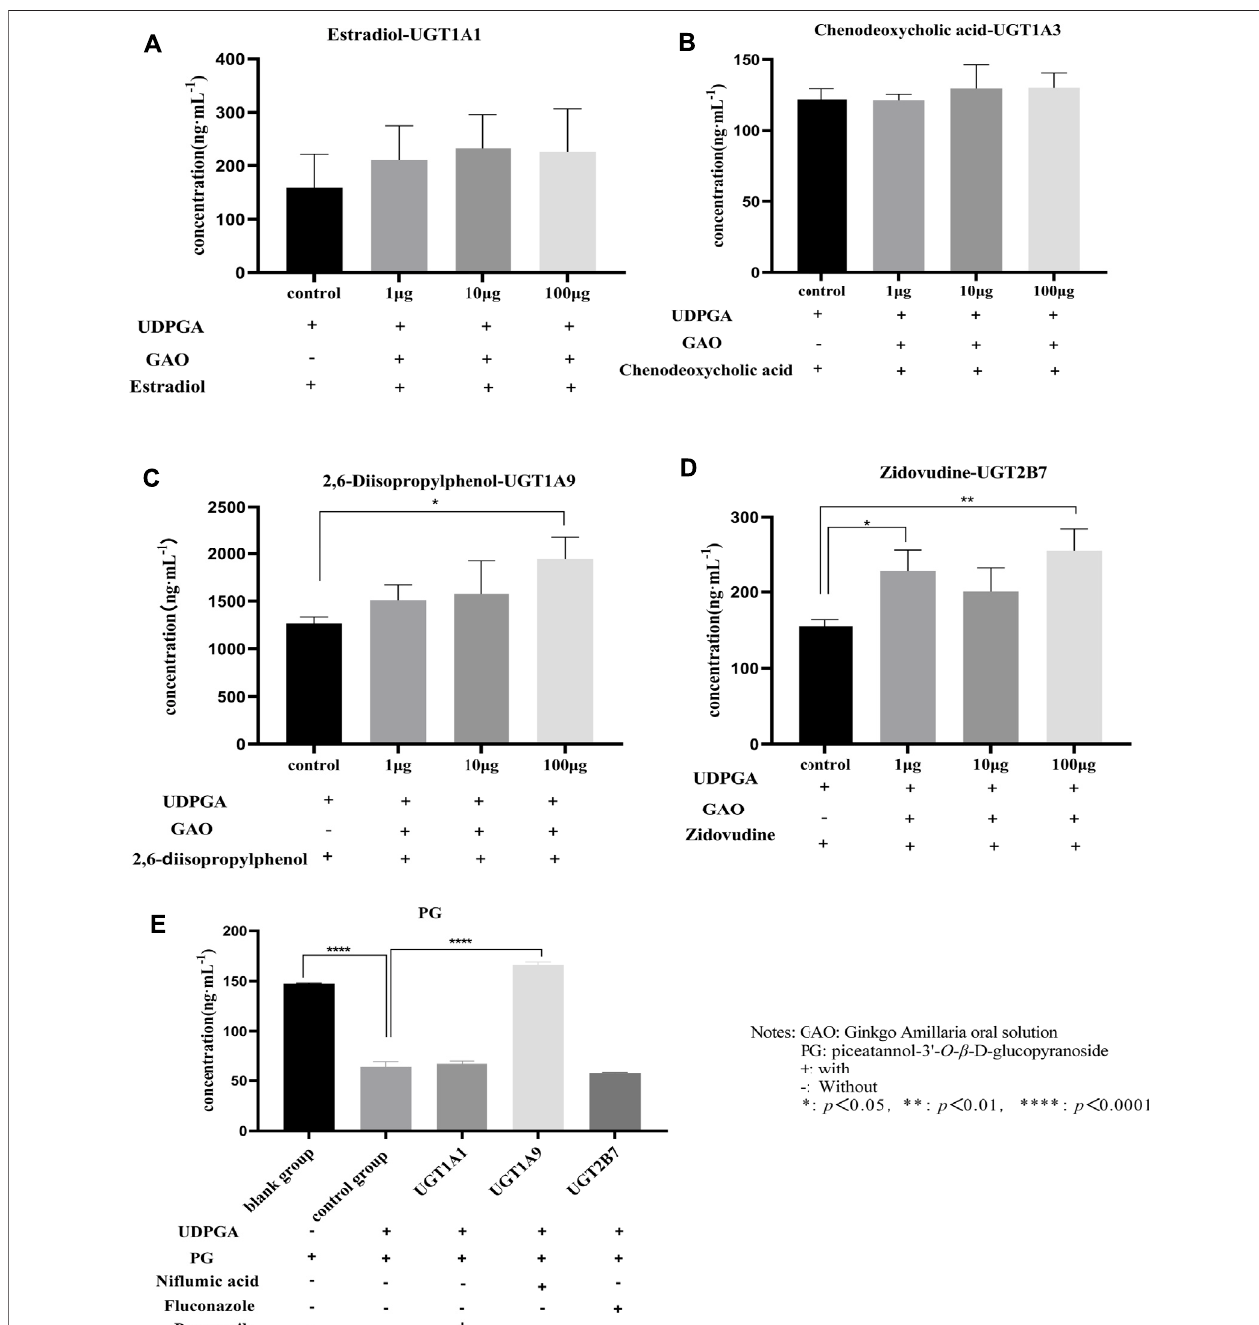
FIGURE3| IncubationoflivermicroparticleswithGAOandPG (A) :estradiol; (B) :chenodeoxycholicacid; (C) :2,6-diisopropylphenol; (D) :zidovudine;and (E) :PG).